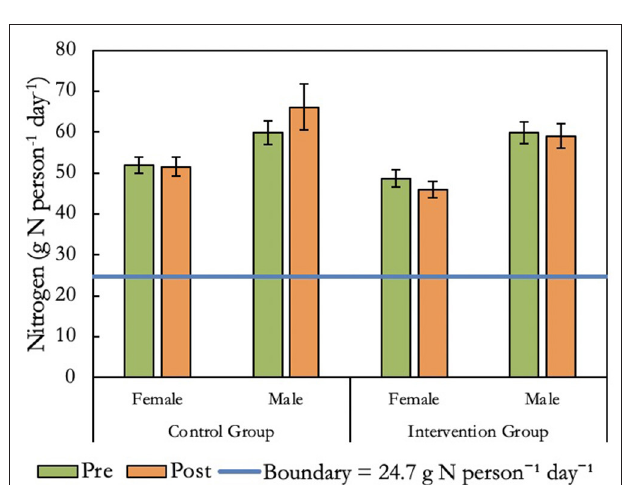
FIGURE 4 | Changes in dietary nitrogen footprint from baseline to follow up for female and male students in the intervention and control group. The per capita food-related planetary boundary of 24.7g N person − 1 day − 1 (for a population of 10 billion in 2050) is shown by the blue